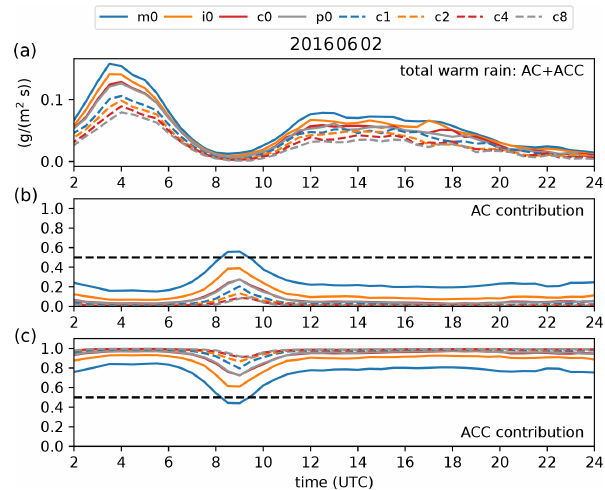
Figure 12. The sum of the warm-rain processes autoconversion AC and accretion ACC (a) , the ratio of the AC contribution to warm- rain formation (b) , and the ratio of the ACC contribution to warm- rain formation (c)